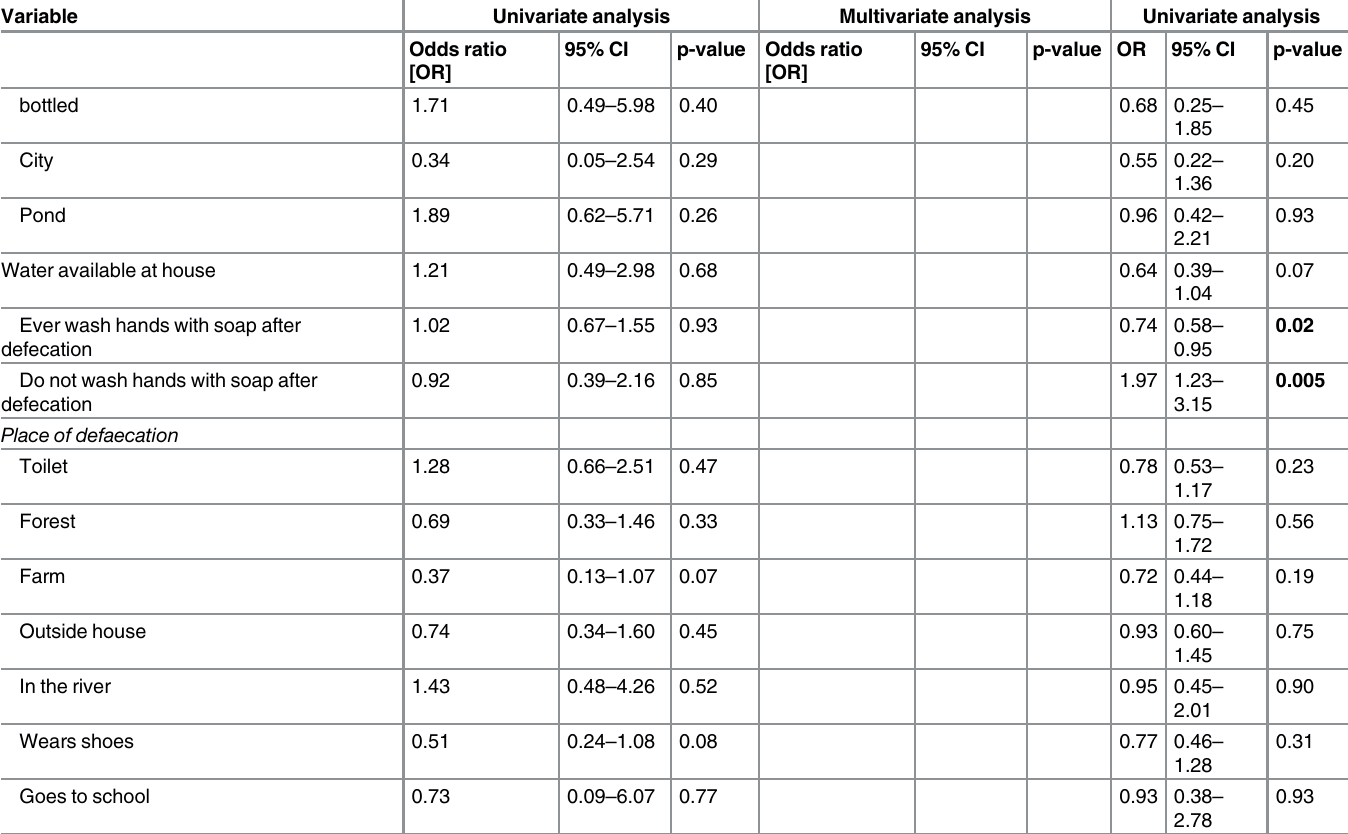
methods to standard microscopy increased the proportion of Cryptosporidium species detected from 1.4% to 7.7% of all faecal samples, with three quarters of positive samples only detected by PCR. Most of the Cryptosporidium species positives were detected in the 1 – 10 year age group with two thirds in the 1 – 5 years age group and one quarter in the 6 – 10 year age group. The proportion of samples positive for G . duodenalis increased from 11.2% to 28.7%